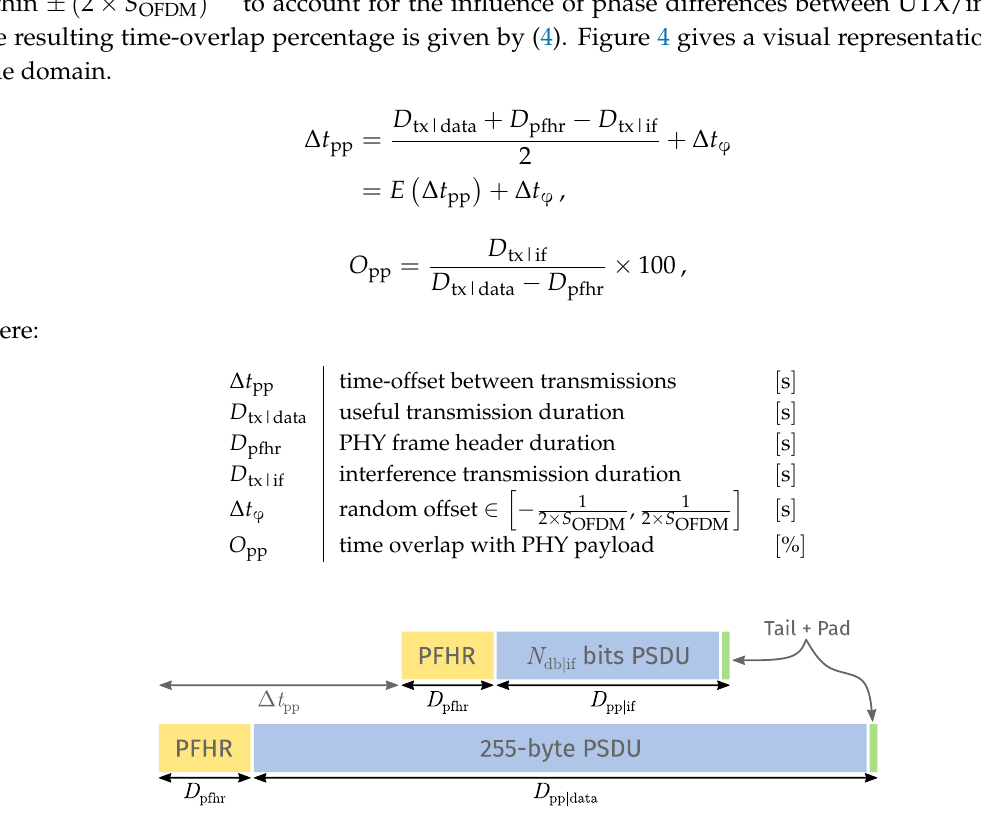
Figure 4. Time-domain overlap between a useful PPDU’s PHY payload ( bottom ) and an interfering PPDU ( top ). The offset ∆ t pp follows from the interference transmit duration D tx|if and its alignment in the center of the useful PHY